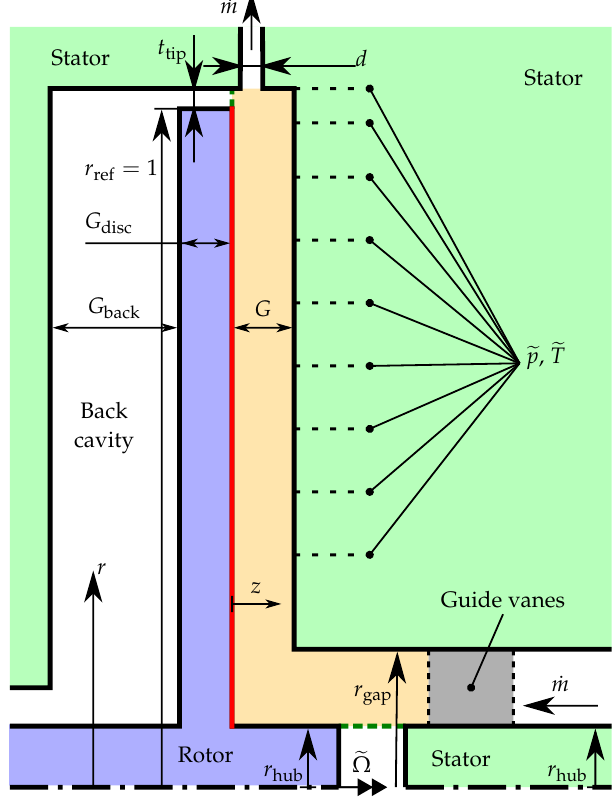
Figure 1. Schematic of the rotor–stator cavity test rig.